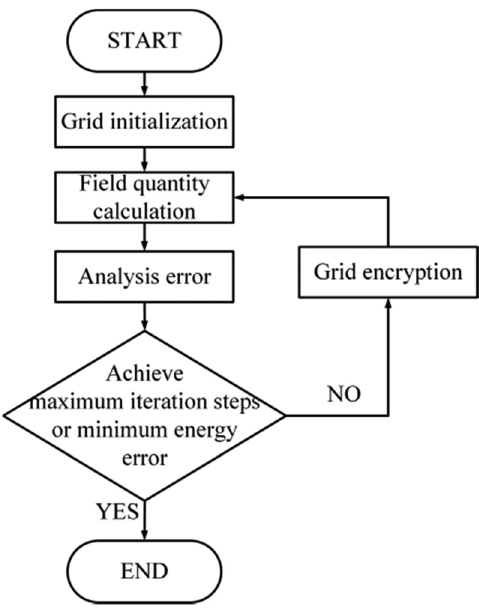
Figure 4: Technical principle of adaptive grid section.